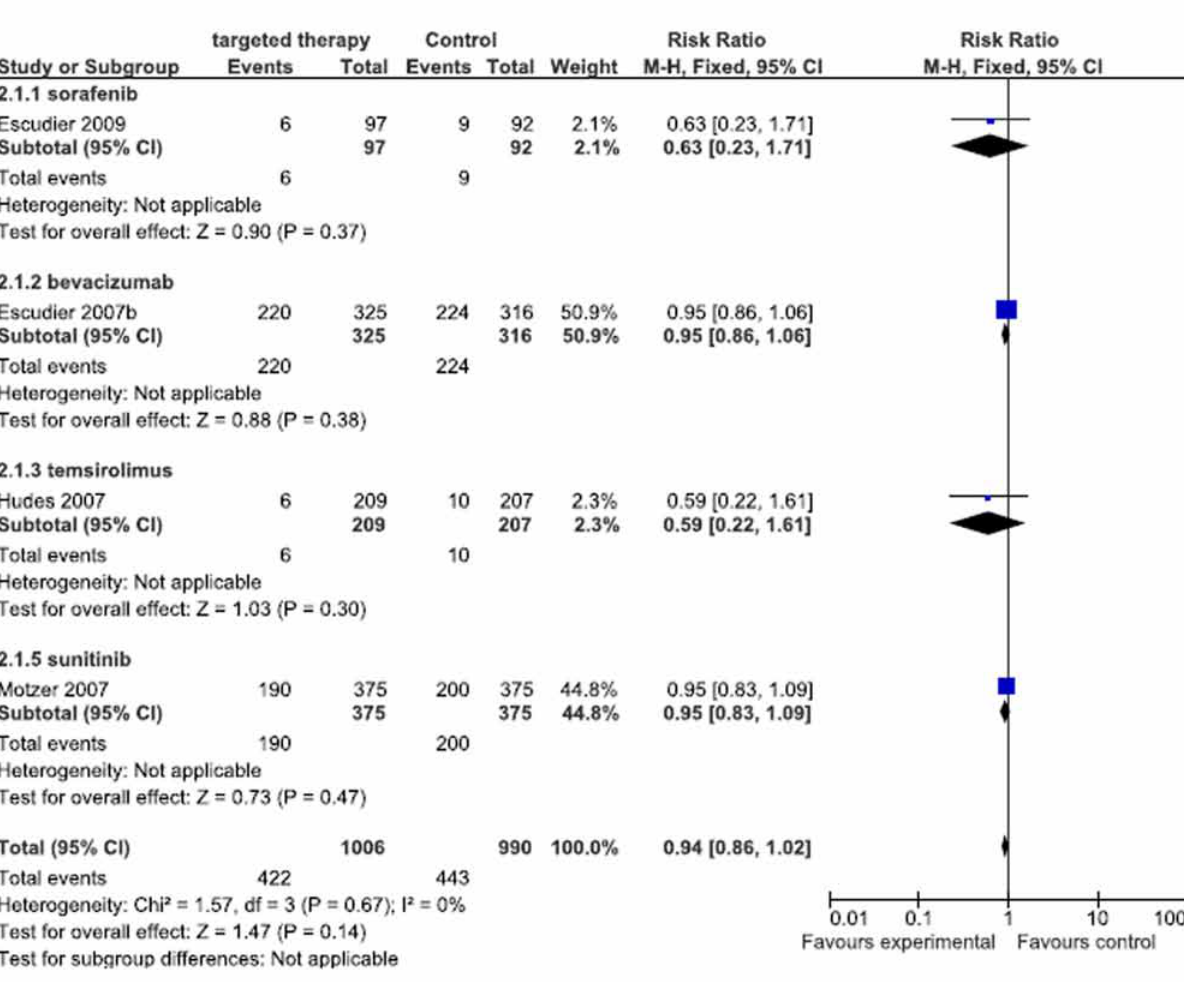
Figure 3 - Meta-analysis of Total